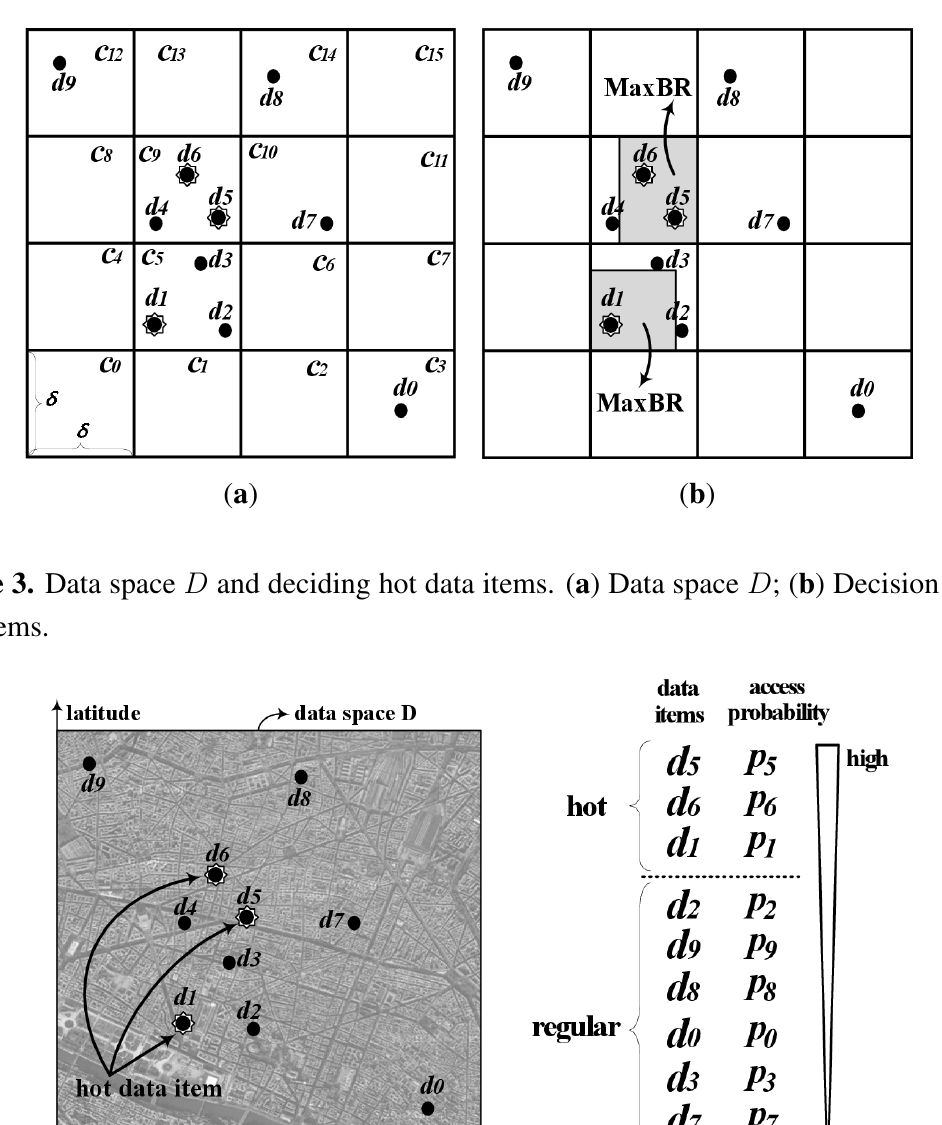
Figure 2. Grid partition and MaxBRs. ( a ) 4 × 4 grid for Figure 3a; ( b ) MaxBR.